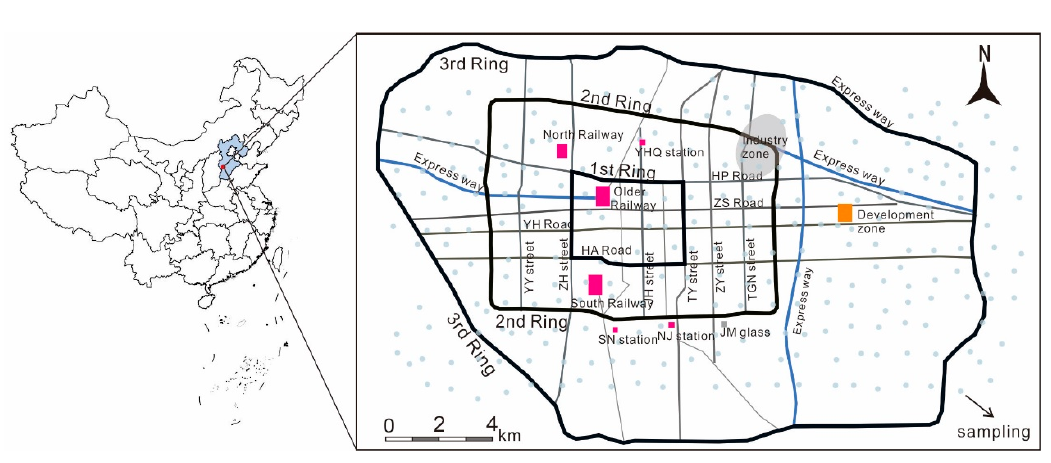
Figure 1. Study area location and map, showing the 1st, 2nd, and 3rd ring roads.